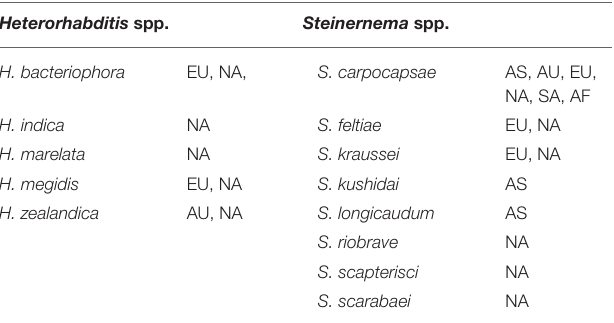
TABLE 1 | Currently or recently commercialized entomopathogenic nematode species and where they are or have been commercialized a . Heterorhabditis